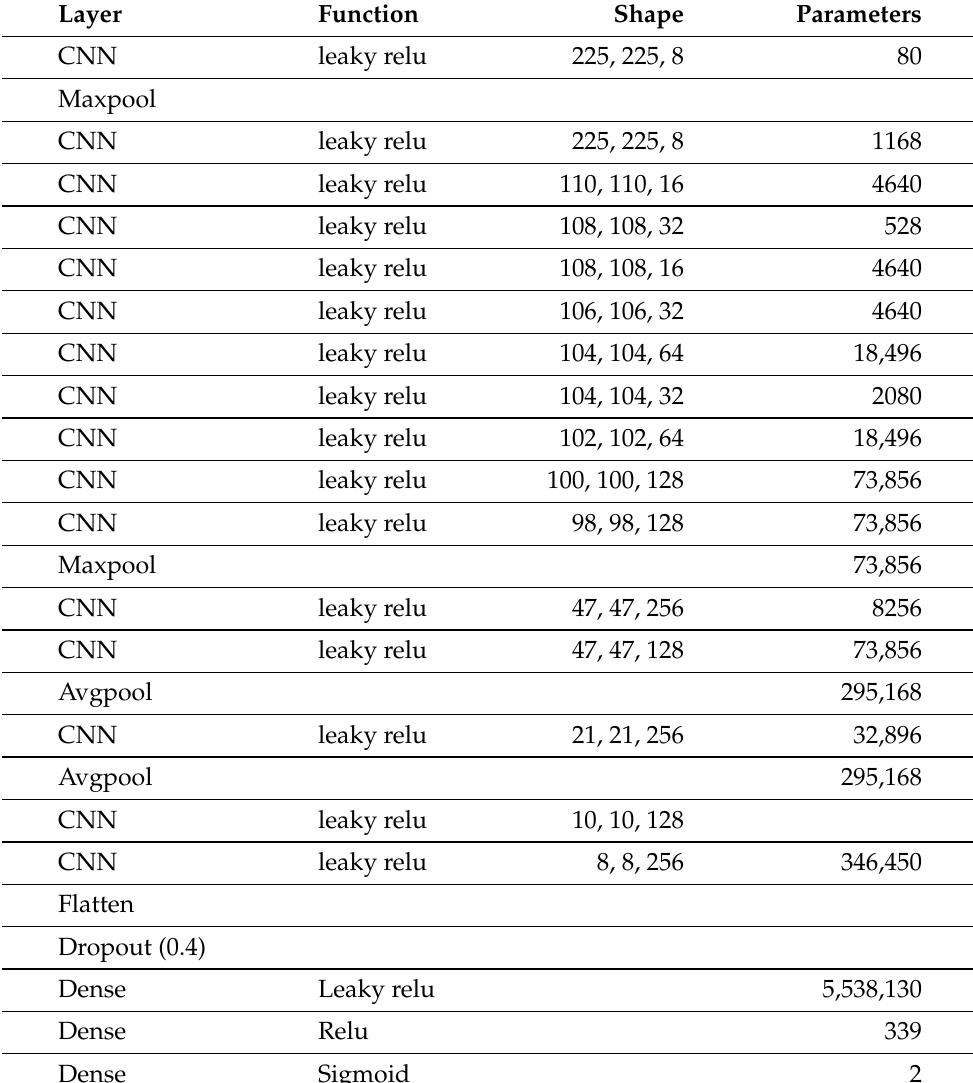
Table A2. Layers of xRGM-NET Version